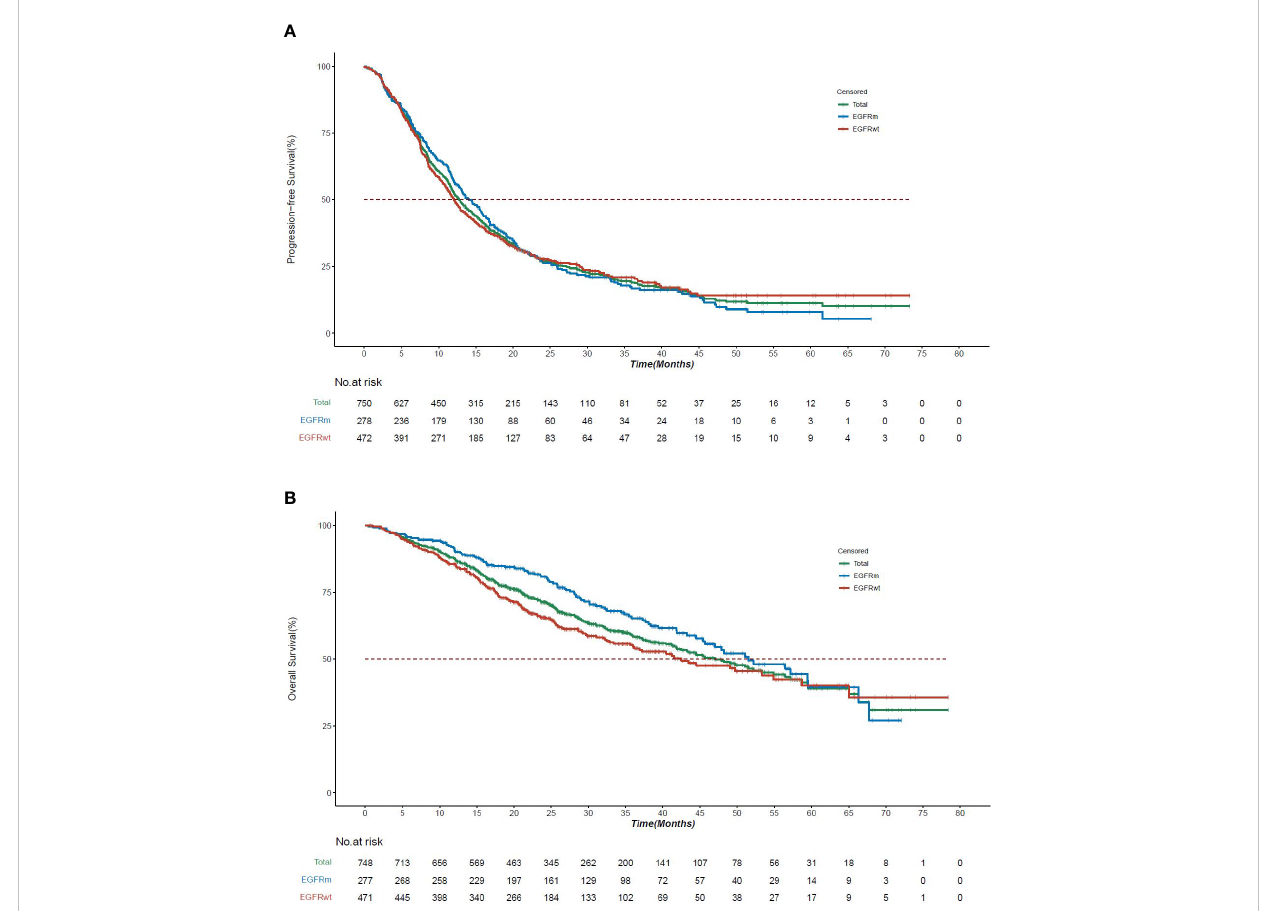
FIGURE 2 Survival curves by EGFR mutation status in KINDLE-Asia. (A) Kaplan-Meier survival curves for progression-free survival by EGFR mutation status. CI=Con fi dence interval; EGFR=Epidermal growth factor receptor; EGFRm=Epidermal growth factor receptor mutation; EGFRwt=Epidermal growth factor receptor wild type mutation; mPFS=Median progression-free survival; NSCLC=Non-small cell lung cancer. Kaplan-Meier survival curves for progression-free survival for all stage III NSCLC patients are shown in green, whereas EGFRm and EGFRwt patients are shown in blue or red, respectively. mPFS for the entire cohort, 12.8 months (95% CI, 12.19 to 13.70). mPFS for EGFRm patients, 14.1 months (95% CI, 12.6 to 16.4). mPFS for EGFRwt patients, 12.0 months (95% CI, 11.1 to 13.6). (B) Kaplan-Meier survival curves for overall survival by EGFR mutation status. CI=Con fi dence interval; EGFR=Epidermal growth factor receptor; EGFRm=Epidermal growth factor receptor mutation; EGFR wt=Epidermal growth factor receptor wild type mutation; mOS=Median overall survival; NSCLC=Non-small cell lung cancer. Kaplan-Meier survival curves for overall survival for all stage III NSCLC patients are shown in green, whereas EGFRm and EGFRwt patients are shown in blue or red, respectively. mOS for the entire cohort, 42.3 months (95% CI, 38.08 to 46.75). mOS for EGFRm patients, 51.5 months (95% CI, 45.4 to 67.7). mOS for EGFRwt patients, 42.5 months (95% CI, 35.7 to 58.7).